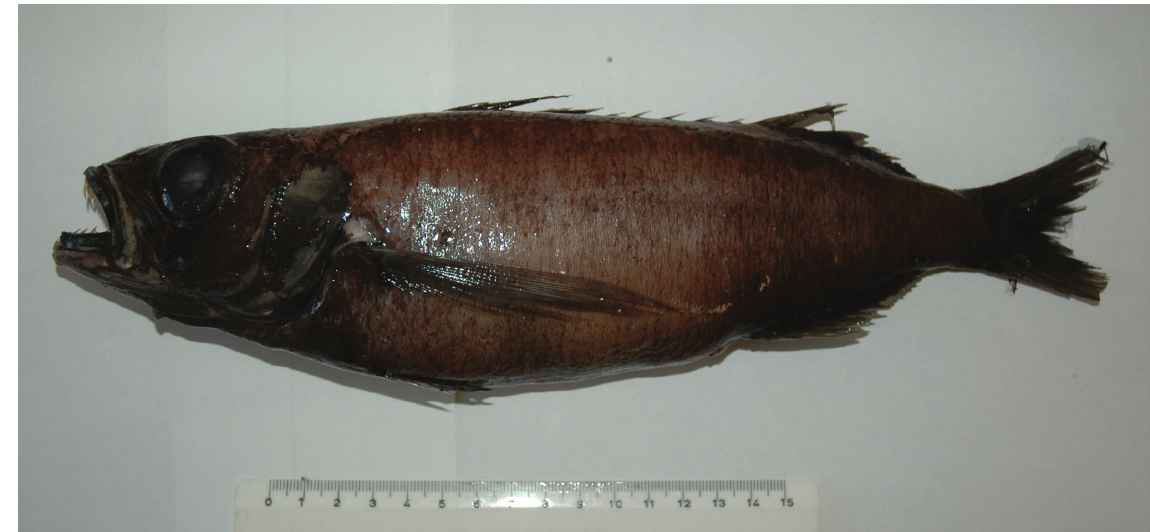
Fig. 4. Scombrolabrax heterolepis Roule, 1921